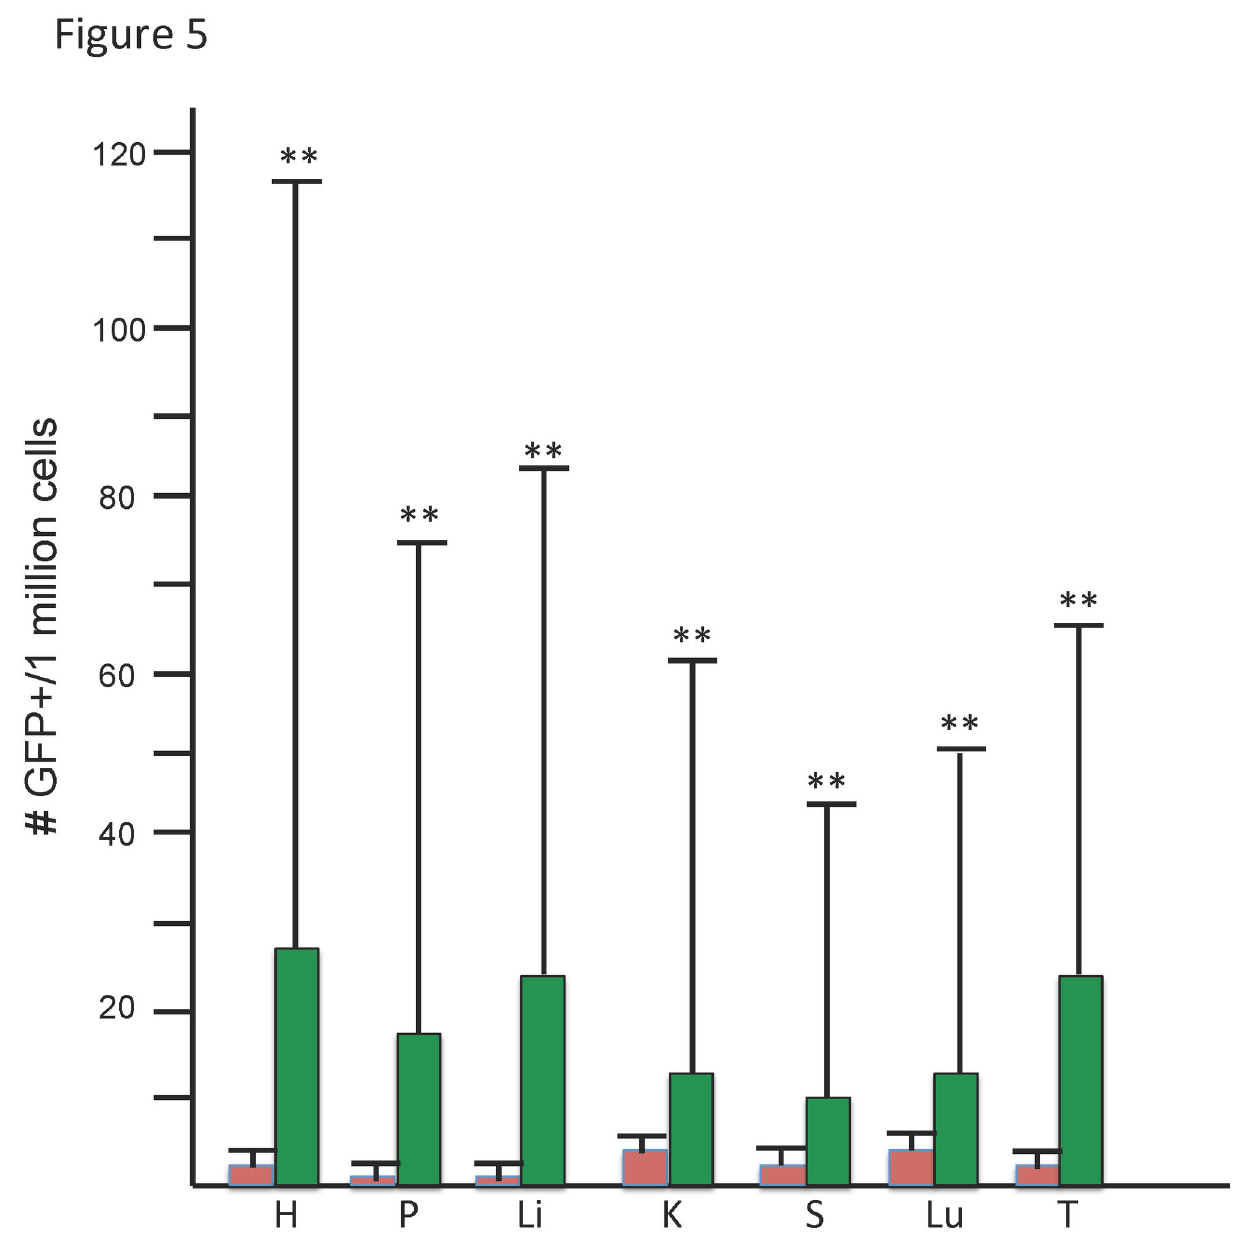
Figure 5. Quantitative analysis of GFP+ cells in all mice analyzed. The number of GFP+ cells in each organ of analyzed mice was determined. Establishment of gates is described in text. From FACS analysis, the average number of GFP+ recombinant cells per million cells and the standard deviation of each was calculated for seven organs and represented in bar graph form. Negative controls are shown in red bars (n=8), and +TET are shown in green bars (n=47). H=heart, P=pancreas, Li=liver, K=kidney, S=spleen, Lu=lung, T=thymus. Organs with statistically significant increased numbers of GFP+ cells groups are indicated by ** above the error